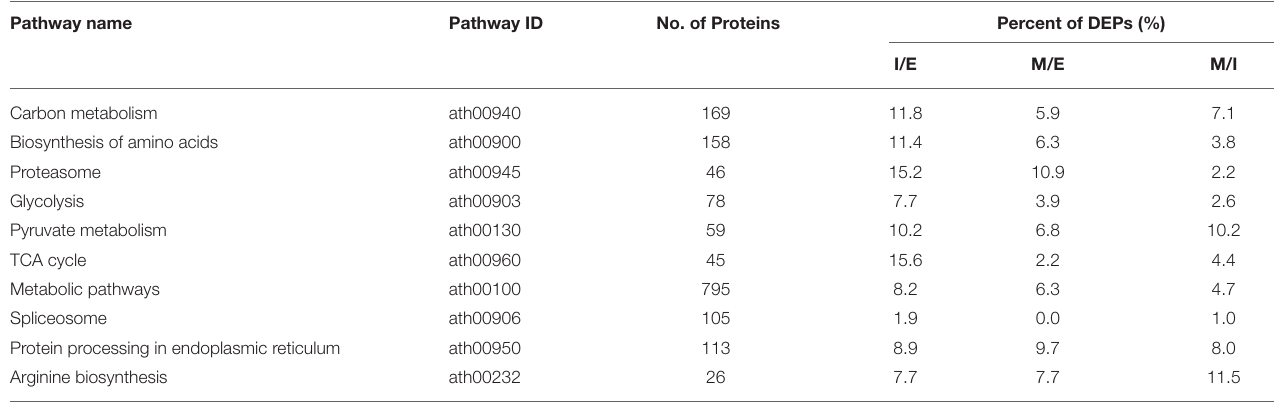
TABLE 1 | KEGG enrichment analysis of differentially expressed proteins in roots of R. glutinosa .